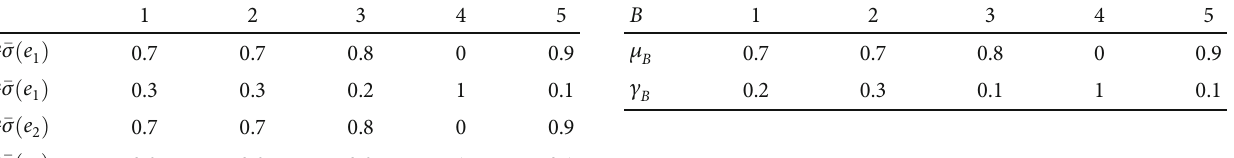
Table 14: Intuitionistic fuzzy set B .